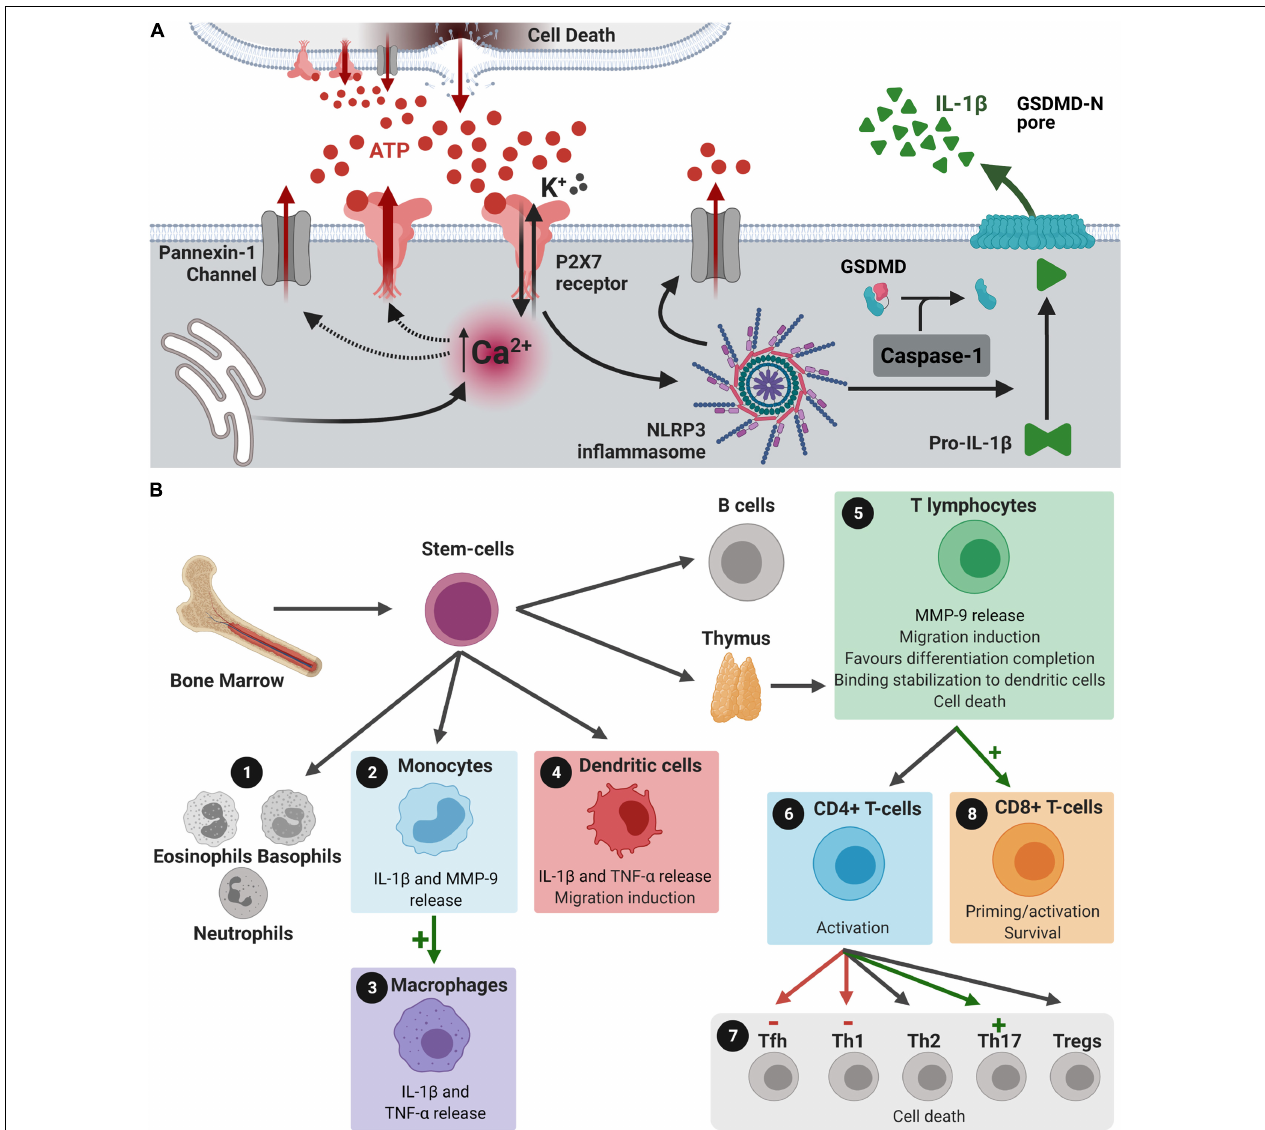
FIGURE 1 | P2X7 receptors in peripheral immune cells and IL-1 β release. (A) Dying cells release ATP. ATP binds and activates P2X7 receptors, which induces Ca 2 + influx and K + efflux. Intracellular Ca 2 + concentration increase induces the formation of large pores by P2X7 receptors and pannexin-1, both allowing the release of more ATP. This results in augmented extracellular ATP concentration and increased activation of P2X7 receptors, providing positive feedback effects. K + efflux induces NLRP3 inflammasome assembly and the formation of more pannexin-1 channels. NLRP3 inflammasome assembly activates caspase-1, which cleaves pro-IL-1 β into IL-1 β and promotes its release. Caspase-1 also cleaves the inhibitory gasdermin (GSDMD)-D-C into the reactive GSDMD-D-N, that interacts with membrane phospholipids to form a pore that allows IL-1 β release. This release could also occur through microvesicles, exosomes or endosomes (not shown). (B) Bone marrow stem cells can differentiate into (1) eosinophils, basophils, neutrophils, (2) monocytes, (4) dendritic cells, (5) T and B lymphocytes. (2) Activation of the P2X7 receptor in monocytes induces the release of MMP-9, which can induce disruption of BBB, and IL-1 β liberation. (3,4) P2X7 receptor activation induces the differentiation of monocytes into macrophages and stimulates the release of IL-1 β and TNF- α from monocytes, macrophages, and dendritic cells. (4) Released IL-1 β stimulates the migration of dendritic cells. (5) In T lymphocytes, P2X7 receptor activation may: release MMP-9, induce the migration of these cells, favor differentiation into CD4 + or CD8 + cells before leaving the thymus, stabilizes its binding to dendritic cells and promote cell death, if necessary. IL-1 β released by dendritic cells through P2X7 receptor stimulation activates CD4 + cells and (6) differentiation of these cells into T helper (Th) 1 and 17, and T follicular helper cells (Tfh). (7) Activation of P2X7 receptors in CD8 + cells promotes activation and survival of these cells, while IL-1 β released by dendritic cells primes CD8 + cells. (8) P2X7 receptor expression is essential for differentiation of T cells into CD8 + cells. Created with